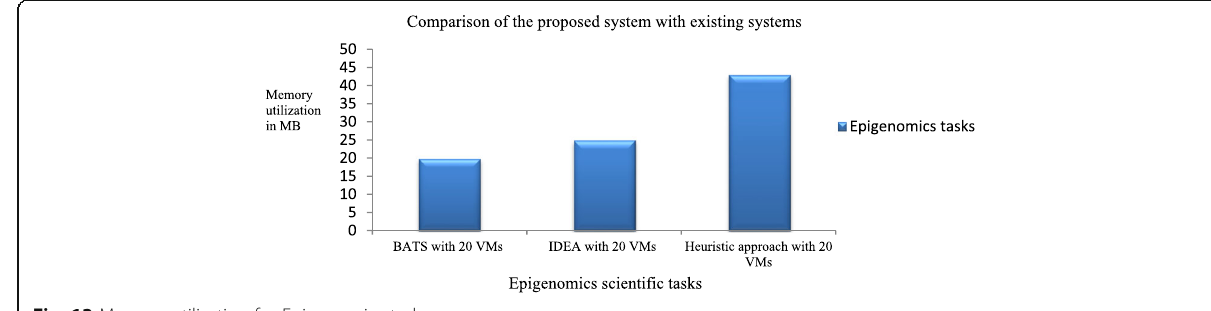
Fig. 13 Memory utilization for Epigenomics task